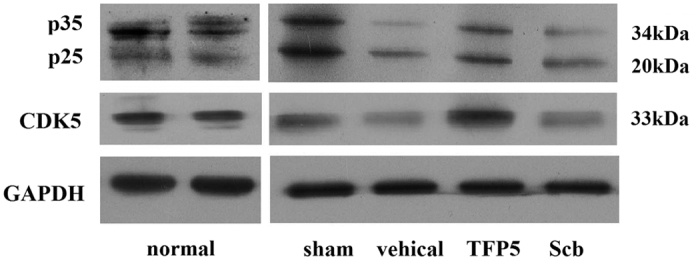
The effect of TFP5 for the level of p25, p35 and CDK5 in the whole ischemic hemispheres with 2-mm-thick coronal slices of rats. In normal rats, p35 expressions were apparently higher than p25.In other all animals, p35 expressions were close or apparently lower than p25, even in sham group, which might be induced by the stress during surgeries. The expressions of p25, p35 and CDK5 in vehicle and Scb animals were lower than sham and TFP5 animals, which indicated the non-ischemic tissues in ischemic hemispheres of animals with TFP5 injection were more than vehicle and Scb animals. Data was from four independent experiments. CDK5, cyclin-dependent kinase 5; GAPDH, glyceraldehyde-3-phosphate dehydrogenase.